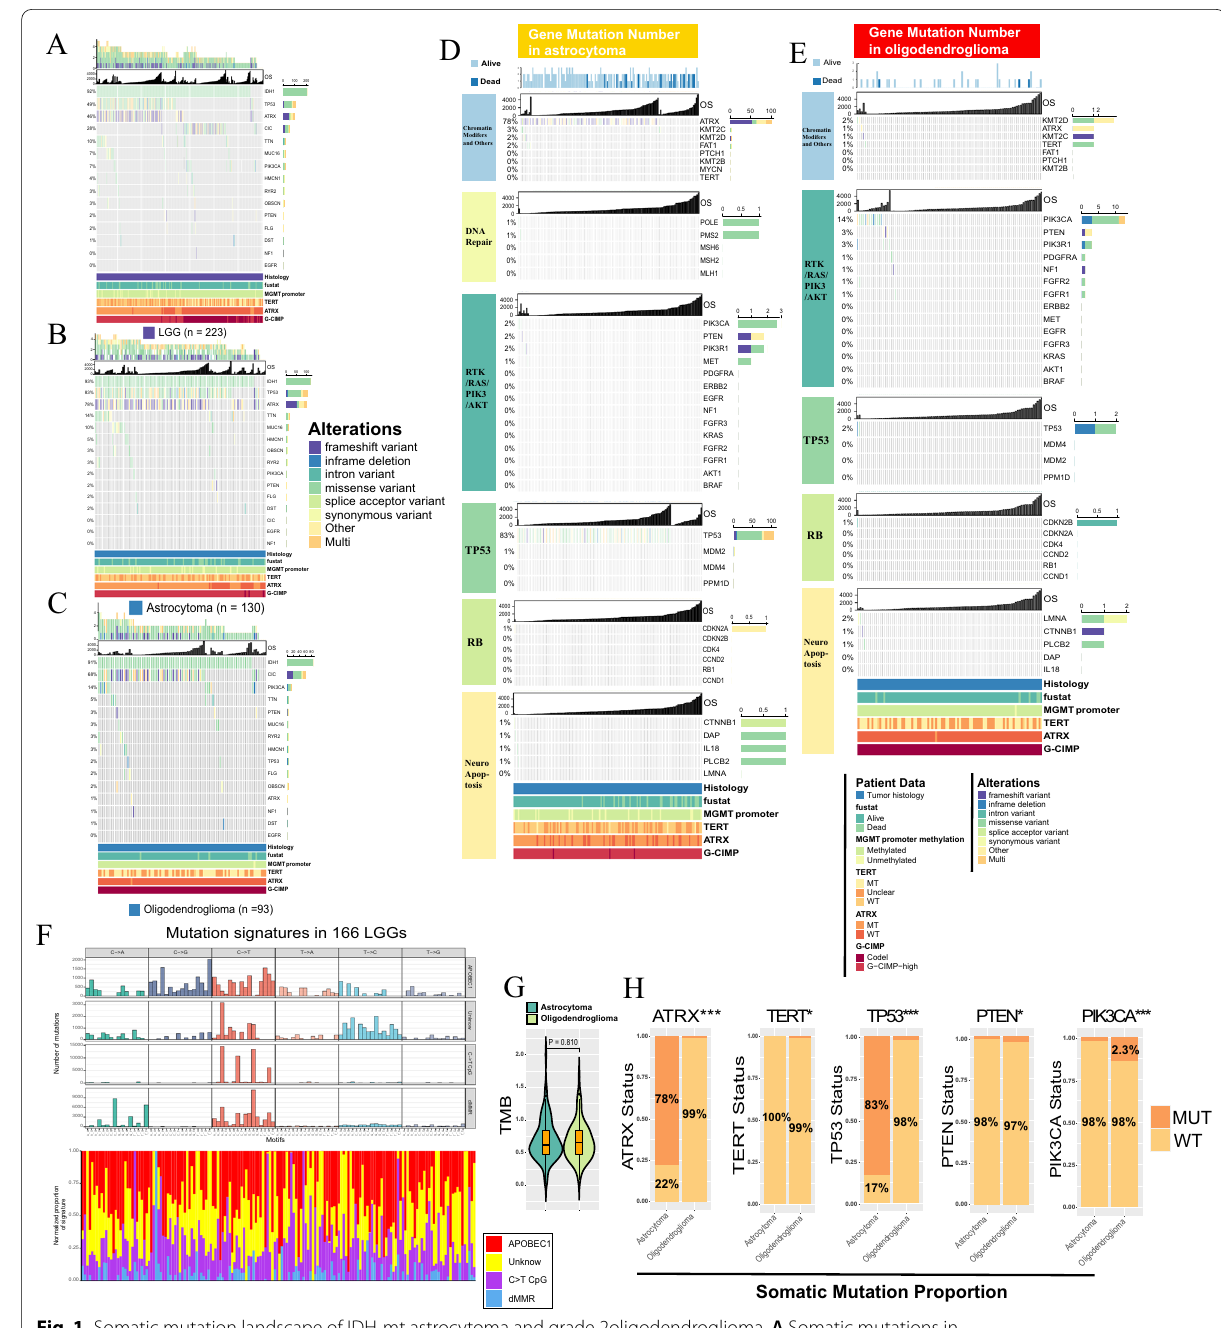
Fig. 1 Somatic mutation landscape of IDH-mt astrocytoma and grade 2oligodendroglioma. A Somatic mutations in astrocytoma oligodendroglioma (n 223). B Somatic mutations in astrocytoma (n 130). C Somatic mutations in oligodendroglioma + = = (n 93). D Somatic mutation frequency of genes in key pathways of astrocytoma. E Somatic mutation frequency of genes in key = pathways of oligodendroglioma. Each column represents an individual patient. The number on the left indicates the mutation frequency, with a bar plot showing the proportion of each variant type. Gene names are indicated on the right. F COSMIC mutation signatures in astrocytoma oligodendroglioma (n 166) by APOBEC1, C > T CpG, dMMR and unknown groups. G . TMB value between astrocytoma and + = oligodendroglioma (Wilcoxon p 0.81). H Proportion of mutated and wild type ATRX , TERT , TP53 , PTEN , and PIK3CA genes between astrocytoma and = oligodendroglioma (*Chi-square test p < 0.05; ***p < 0.001). TMB tumor mutation